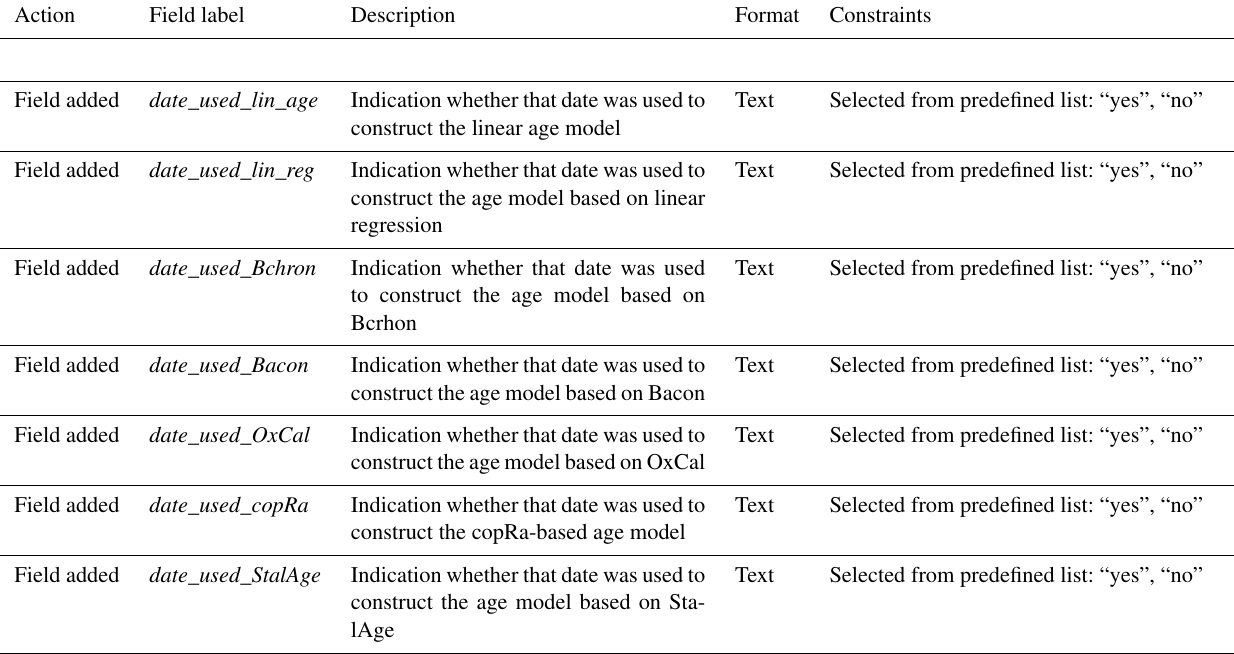
Table 2. Changes made to the dating table to accommodate the new age models. These changes are marked with (*) in Fig.